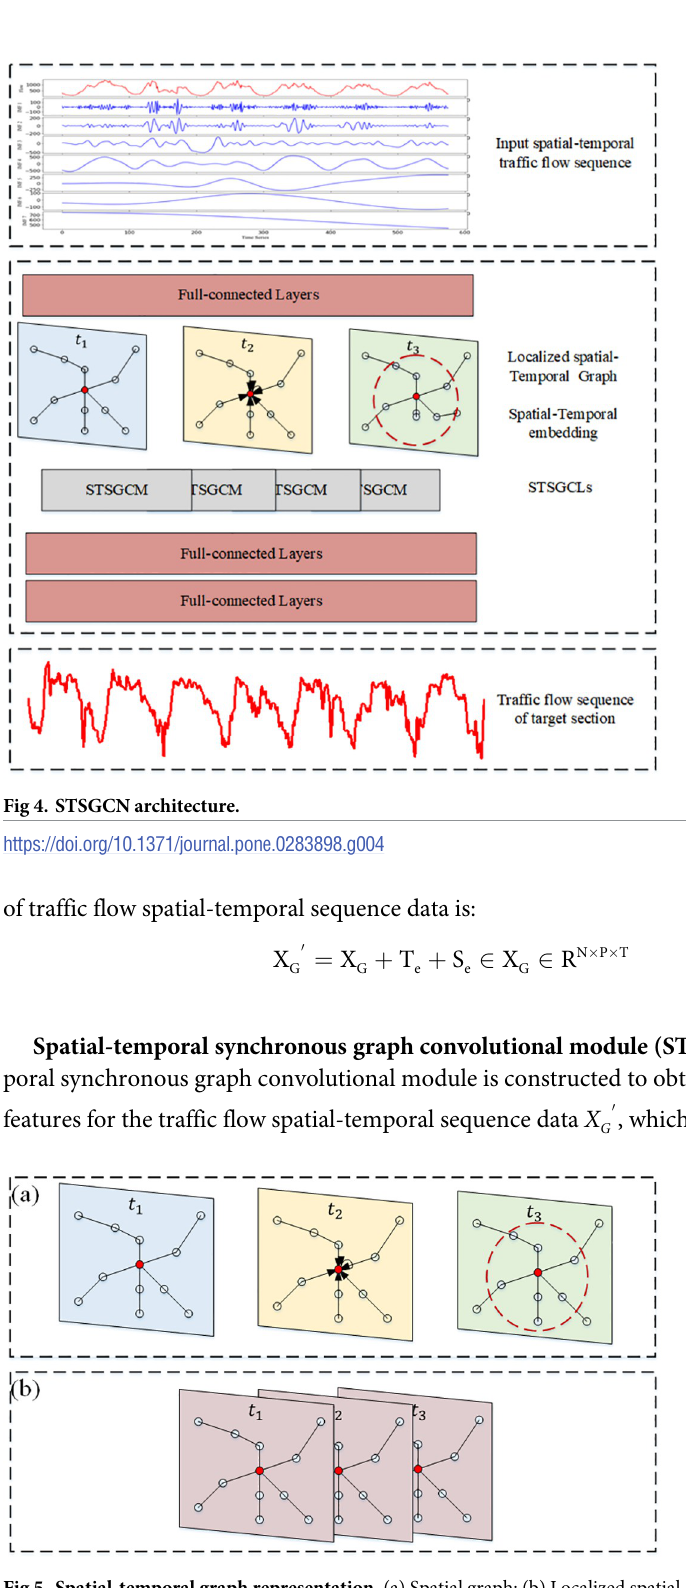
Fig 5. Spatial-temporal graph representation. (a) Spatial graph; (b) Localized spatial-temporal